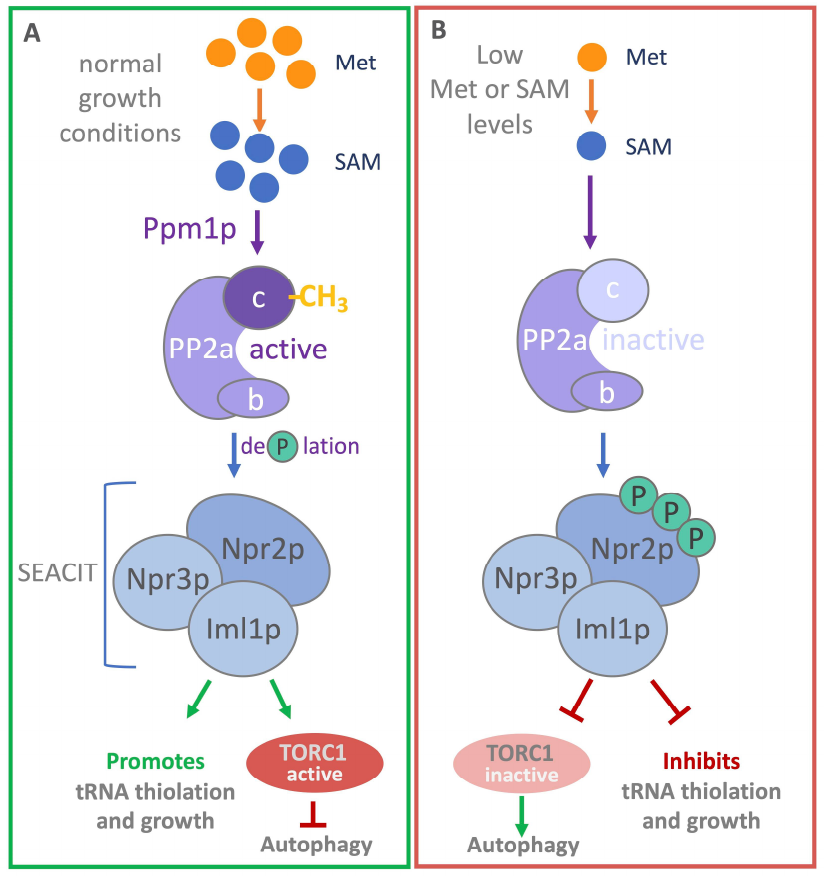
Figure 3. SAM-responsive methylation of PP2a. ( A ) Under normal growth condition, when methionine and SAM are plentiful, PP2A is activated by methylation of its catalytic subunit by Ppm1p. Active PP2a dephosphorylates Npr2p, a component of the autophagy repressing complex SEACIT (SEAC subcomplex Inhibiting TORC1 signaling). Growth is promoted and autophagy is inhibited by active TORC1. ( B ) When methionine or SAM levels are low, PP2A is not methylated and therewith inactive, leading to hyperphosphorylated Npr2p. Under these conditions growth is repressed, TORC1 is inactive, and autophagy is promoted.